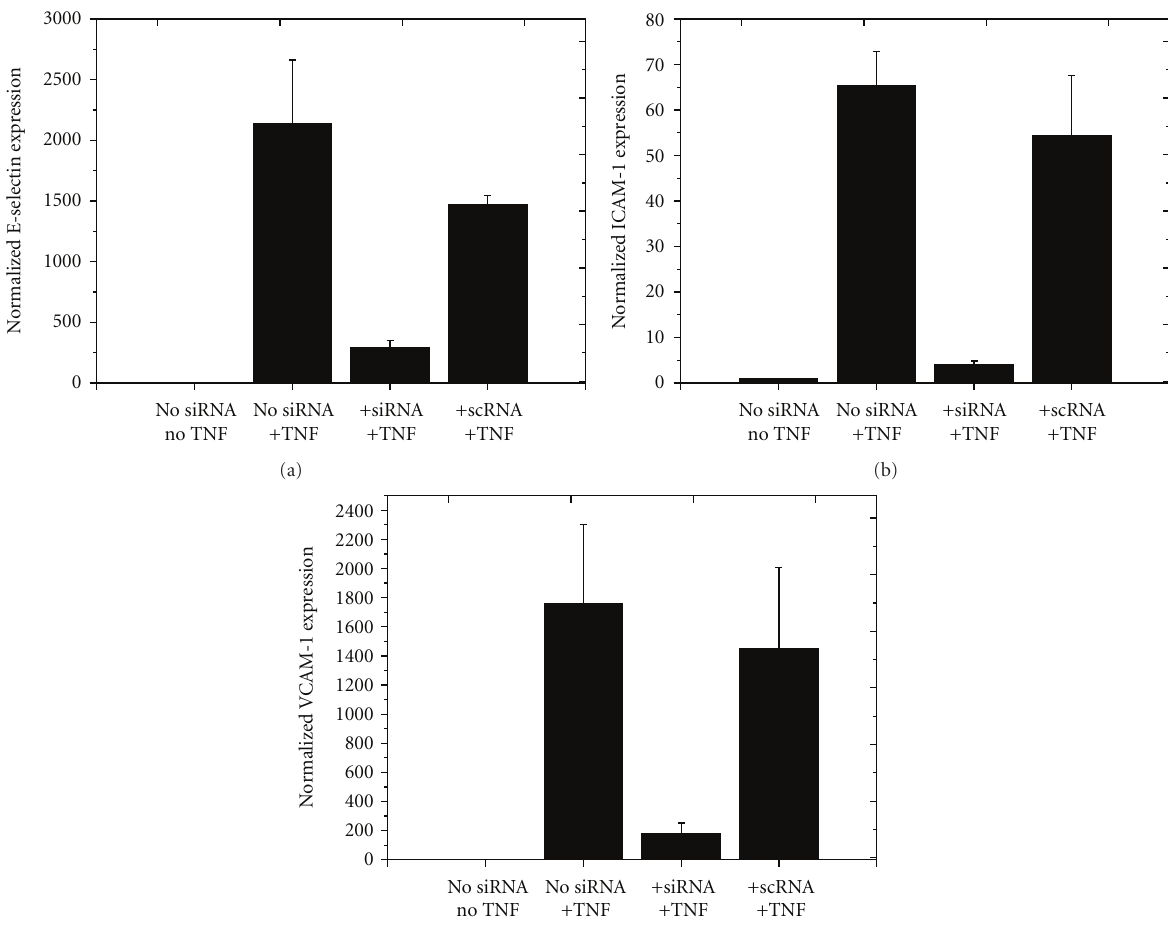
Figure 4: E ff ects of siRNA and TNF- α treatment on ESELE, ICAM-1, and VCAM-1 mRNA levels. Transcript levels were examined by real- time RT-PCR. Each bar represents the mean ± SD of three independent experiments. Gene expression was normalized in relation to group 1, which was set to the value of 1.00. Group 1: HLMECs without siRNA transfection and without TNF- α stimulation; group 2: HLMECs without siRNA transfection, but with TNF- α stimulation; group 3: HLMECs transfected with a receptor specific siRNA and with TNF- α stimulation; group 4: HLMECs transfected with a nonspecific siRNA and with TNF- α